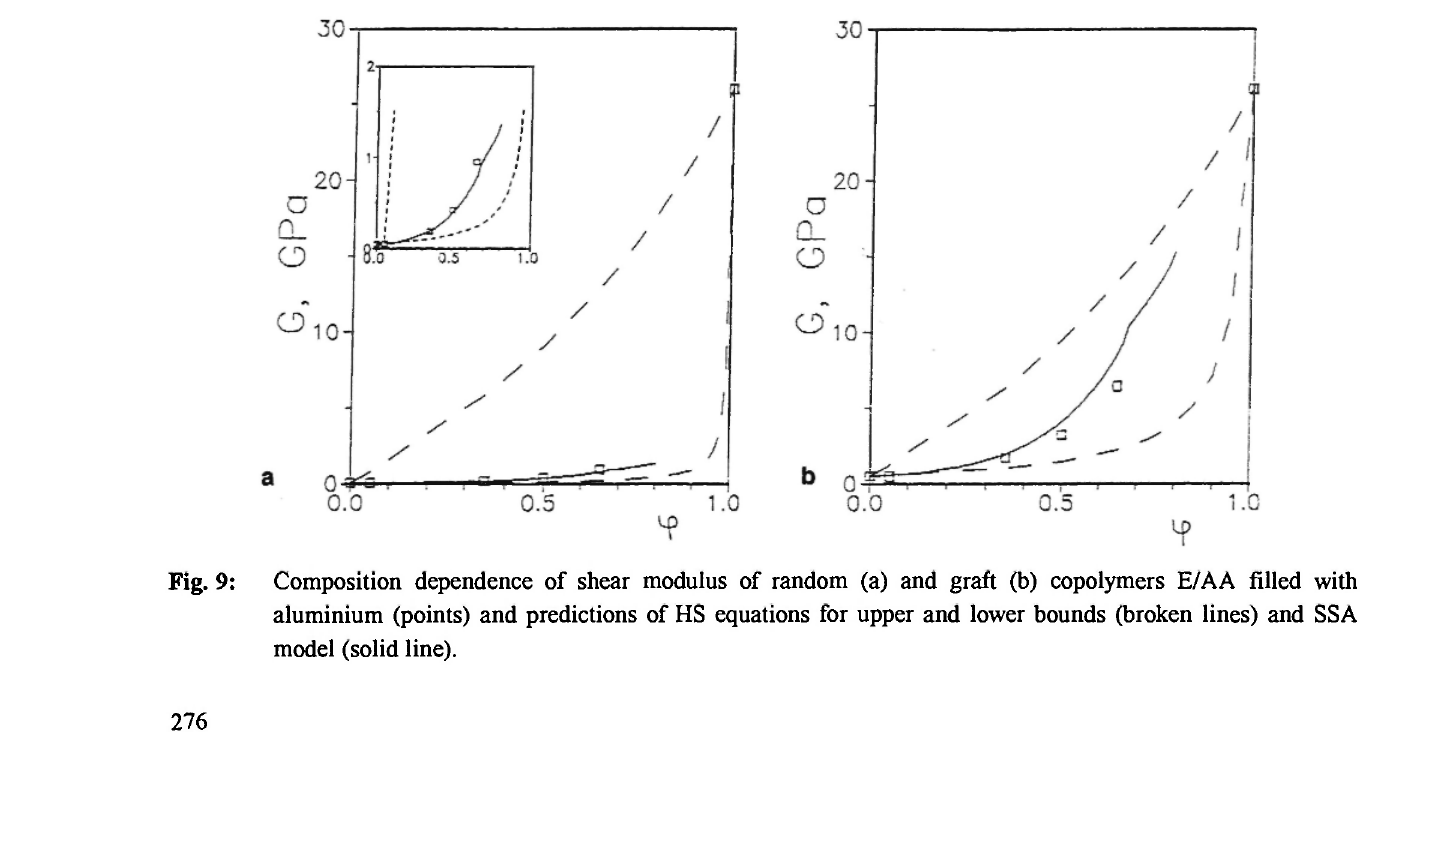
Fig. 8: Composition dependence of shear modulus of PE filled with aluminium (points) and predictions of HS equations for upper and lower bounds (broken lines) and SSA model (solid line).